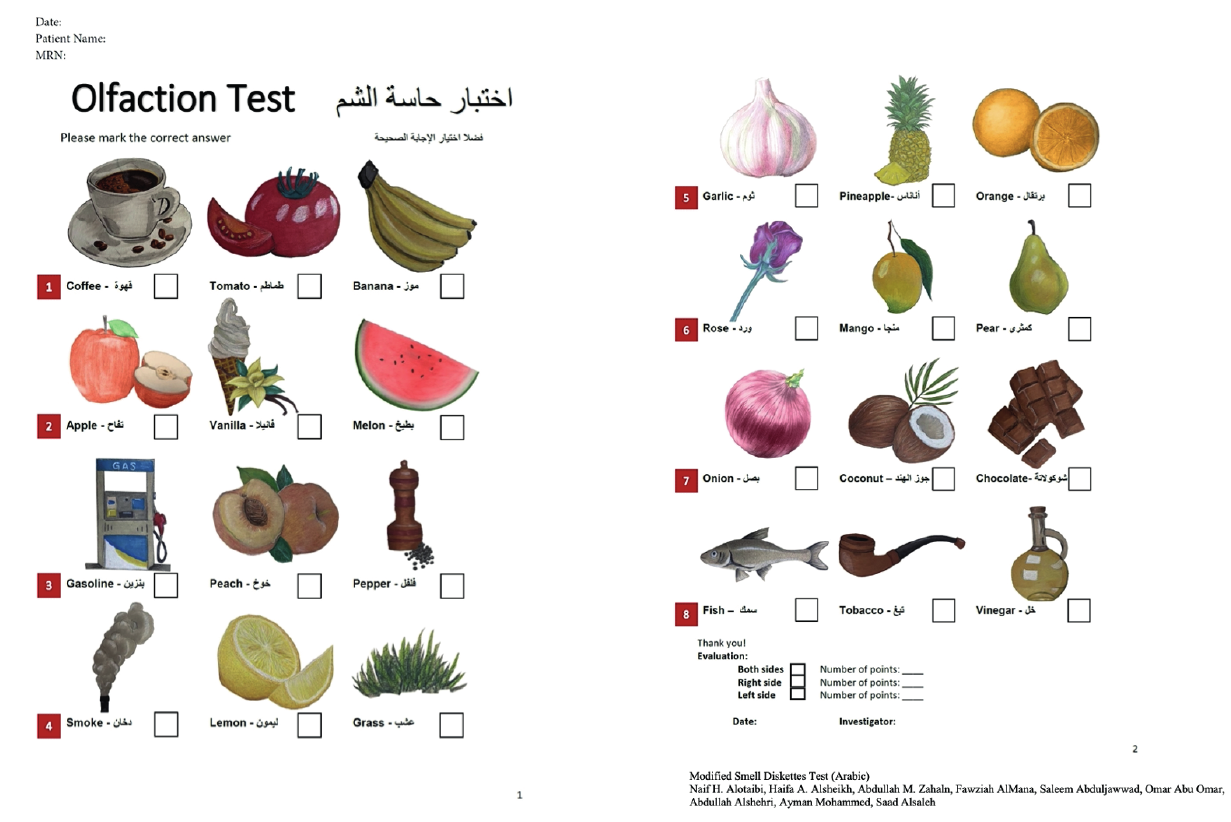
Figure 2. Arabic Translation of the "Smell Diskettes"